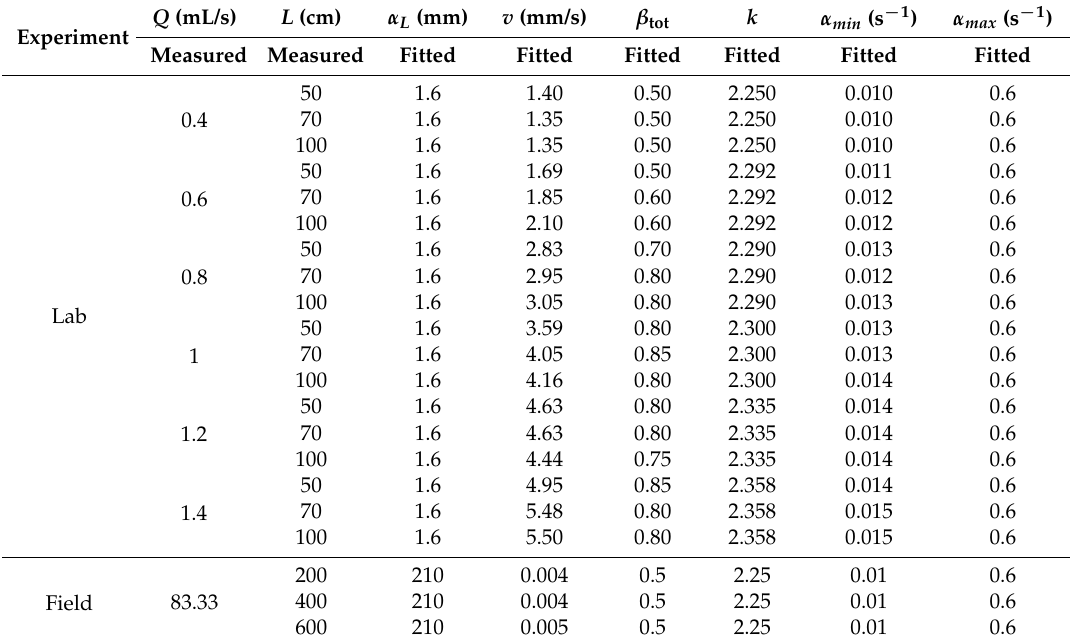
Table 5. The best-fit parameters for the power-law MRMT model 4 at different flow rates and travel distances. In the legend, k stands for the slope of the late-time tail, and α min and α max stand for the lower and upper boundary of the mass transfer rates,